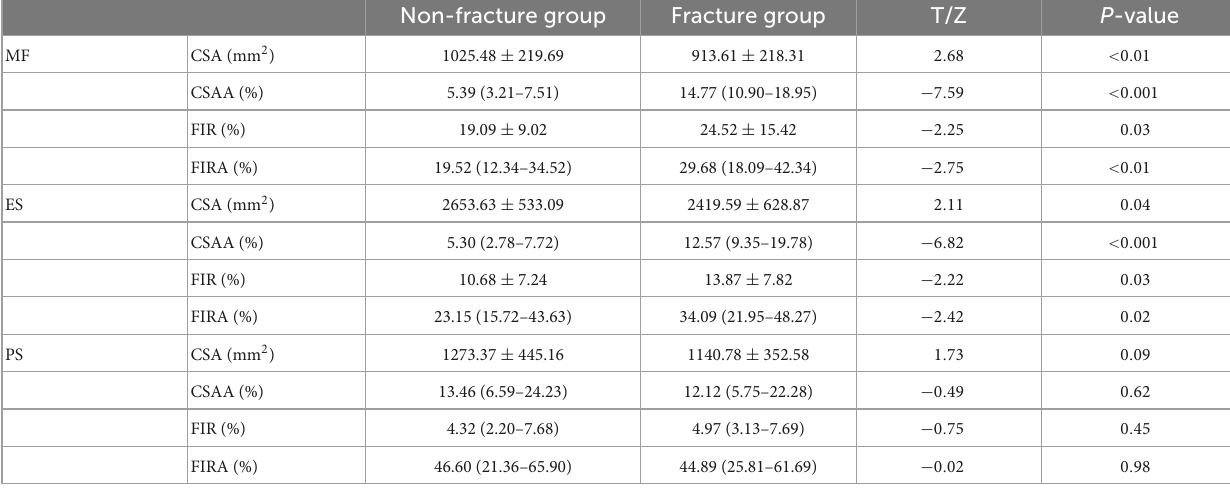
TABLE 2 Difference of paraspinal muscles parameters between the two groups. Non-fracture